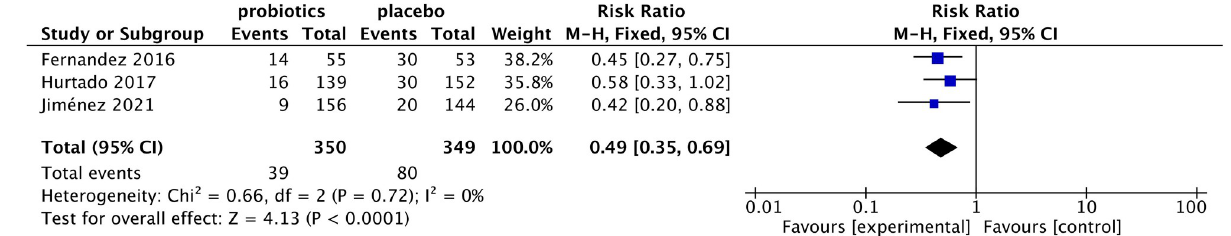
Fig 4. Forest plot of the incidence of lactation